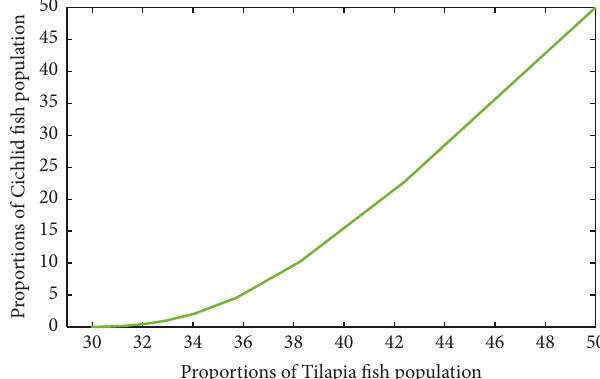
Figure 6: The interaction between cichlid and tilapia fishes in absence of Nile